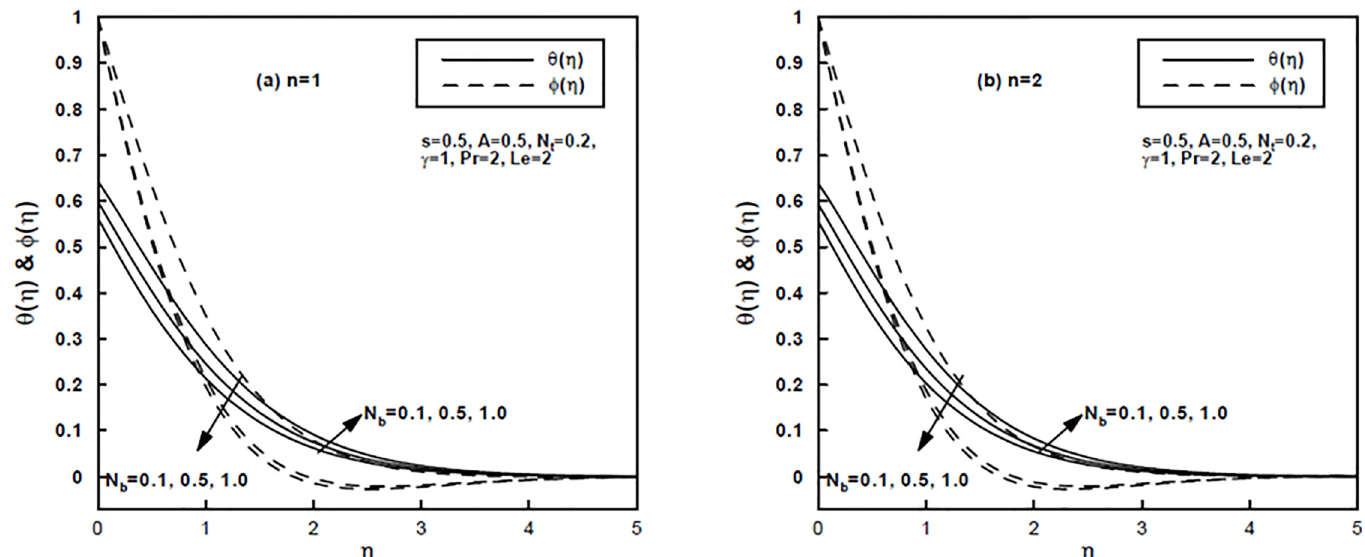
Fig 5. (a,b), The temperature and concentration profiles for different values of the Brownian motion parameter N b .